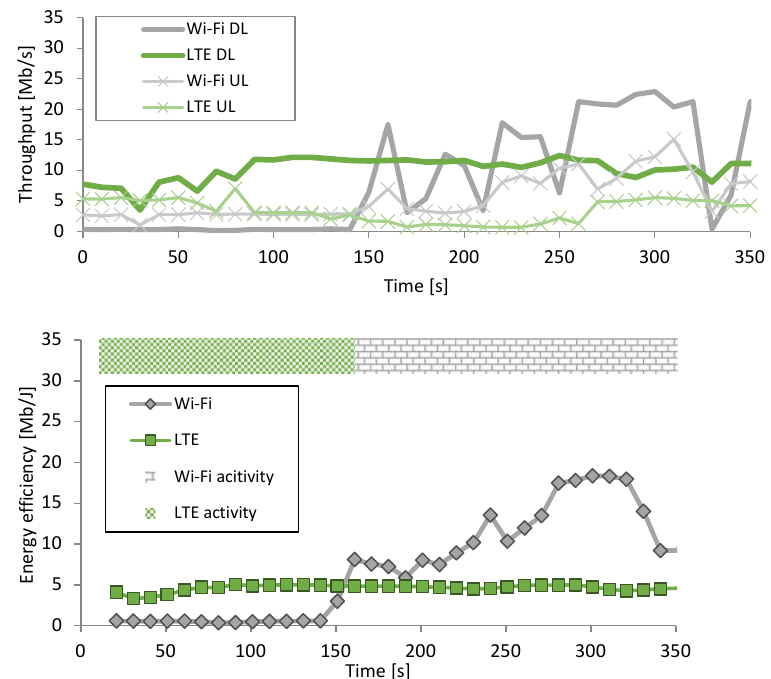
Figure 6. Scenario A—( Top ) Instantaneous throughput from UE perspective. ( Bottom ) Energy efficiency from UE perspective for different RAT with the indication of which network is selected by the orchestrator to maintain user data transfer.